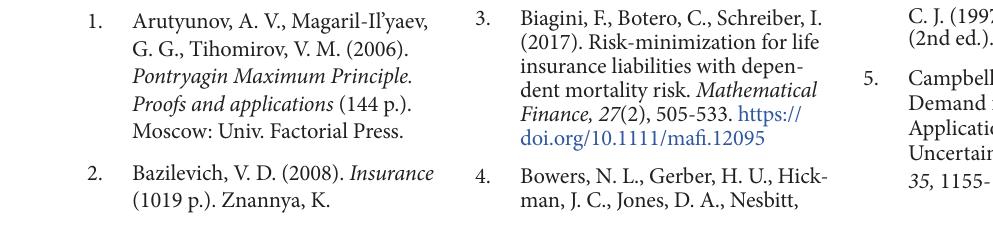
Figure 8. Distribution of the present actuarial value of benefits for the case of mixed life insurance (Option